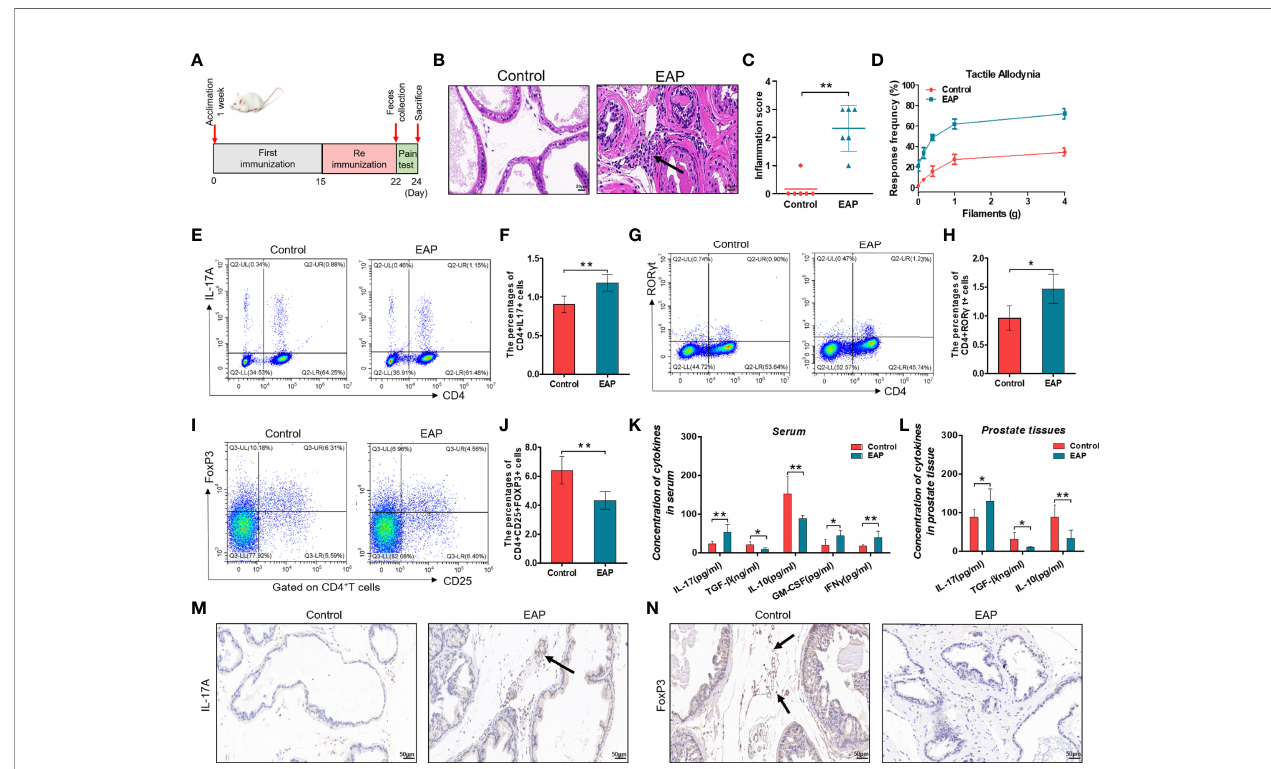
FIGURE 1 | Evaluation of the EAP model, proportion of Th17/Treg cells, and levels of related in fl ammatory cytokines. (A) After 1 week of acclimation, mice received primary and secondary immunization on days 0 and 15, respectively. Modeling was completed 1 week later, followed by feces collection and pain measurement for 2 days. Mice were sacri fi ced on day 24 and then samples were collected. (B) Representative HE staining images of prostate tissue sections of the control and EAP group. The black arrowhead indicates in fi ltration of in fl ammatory cells in the EAP group. (C) In fl ammation score of prostate in the control and EAP group. (D) EAP induced pelvic pain as evaluated by tactile allodynia. (E) Representative pictures of fl ow cytometric staining for CD4 + IL-17 + cells in the splenic lymphocytes from control and EAP mice. (F) Flow cytometric analysis of the proportion of CD4 + IL-17 + cells in control and EAP mice. (G) Representative pictures of fl ow cytometric staining for CD4 + ROR g t + cells in the splenic lymphocytes from control and EAP mice. (H) Flow cytometric analysis of the proportion of CD4 + ROR g t + cells in control and EAP mice. (I) Representative pictures of fl ow cytometric staining for CD4 + CD25 + FoxP3 + cells in the splenic lymphocytes from control and EAP mice. (J) Flow cytometric analysis of the proportion of CD4 + CD25 + FoxP3 + cells in control and EAP mice. (K) Serum concentrations of IL-17, TGF- b , IL-10, GM-CSF, and IFN g by ELISA in the control and EAP group. (L) Concentrations of IL-17, TGF- b , and IL-10 in 10-mg prostate tissues in the control and EAP group. (M) Immunohistochemical staining of IL-17A (marker of Th17) on prostate sections in the control and EAP group. (N) Immunohistochemical staining of FoxP3 (marker of Treg) on prostate sections in the control and EAP group. The black arrows indicate the IL-17/FoxP3-positive cells in the two groups. Data are from one experiment representative of three independent experiments. n = 5 – 6/group; * p < 0.05; ** p < 0.01; EAP, experimental autoimmune prostatitis; HE, hematoxylin – eosin; IL-17, interleukin-17; ROR g t, retinoic acid − related orphan receptor g t; GM-CSF, granulocyte-macrophage colony stimulating factor; IFN g , interferon gamma; TGF- b , transforming growth factor- b ; IL-10, interleukin-10; FoxP3, forkhead box P3; Treg, regulatory T